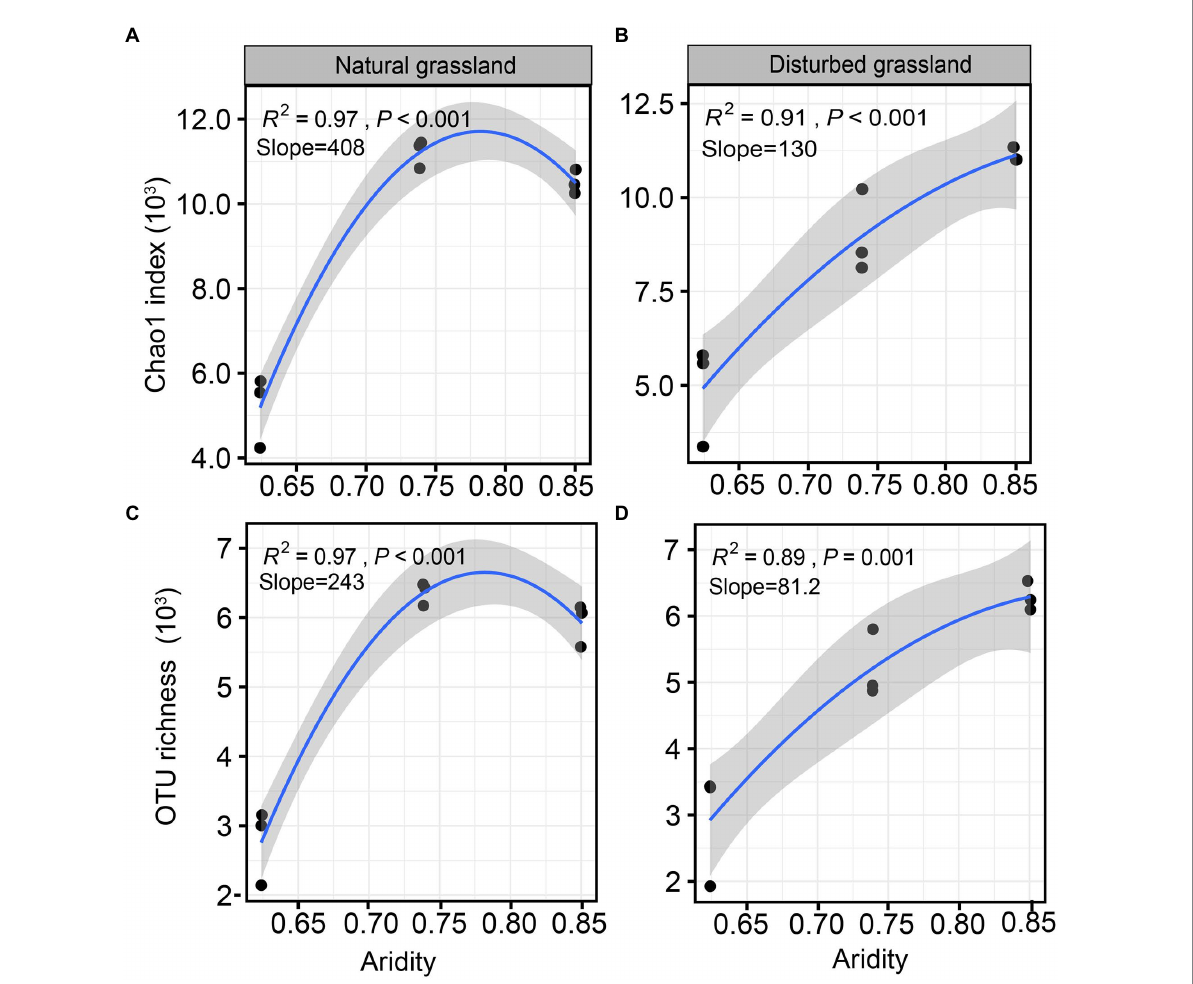
FIGURE 2 Relationships between aridity and α -diversity indexes (Chao1 index and OTU richness) of soil pqqC community in natural (A,C) and disturbed (B,D)